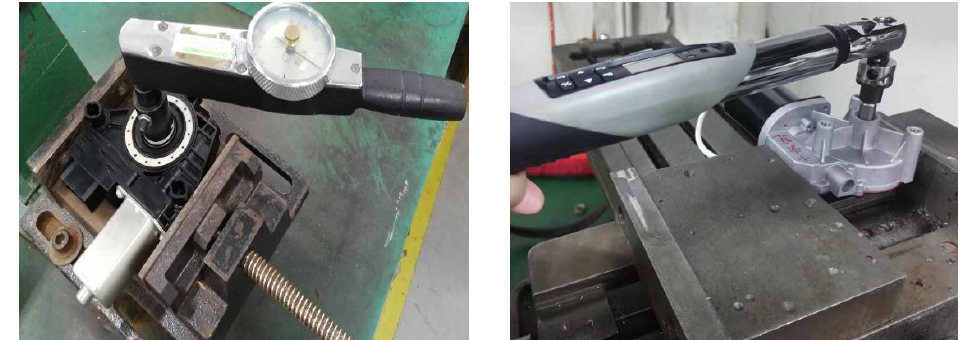
Figure 19. Gearbox samples.